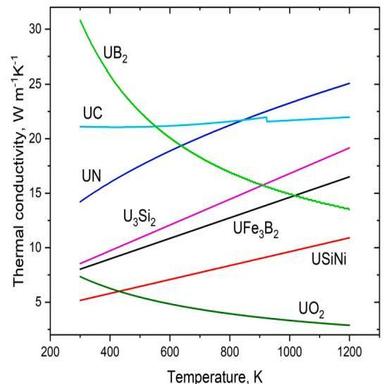
Thermal conductivity of UFe3B2, USiNi, and other established nuclear fuels from 300 to 1200 K.